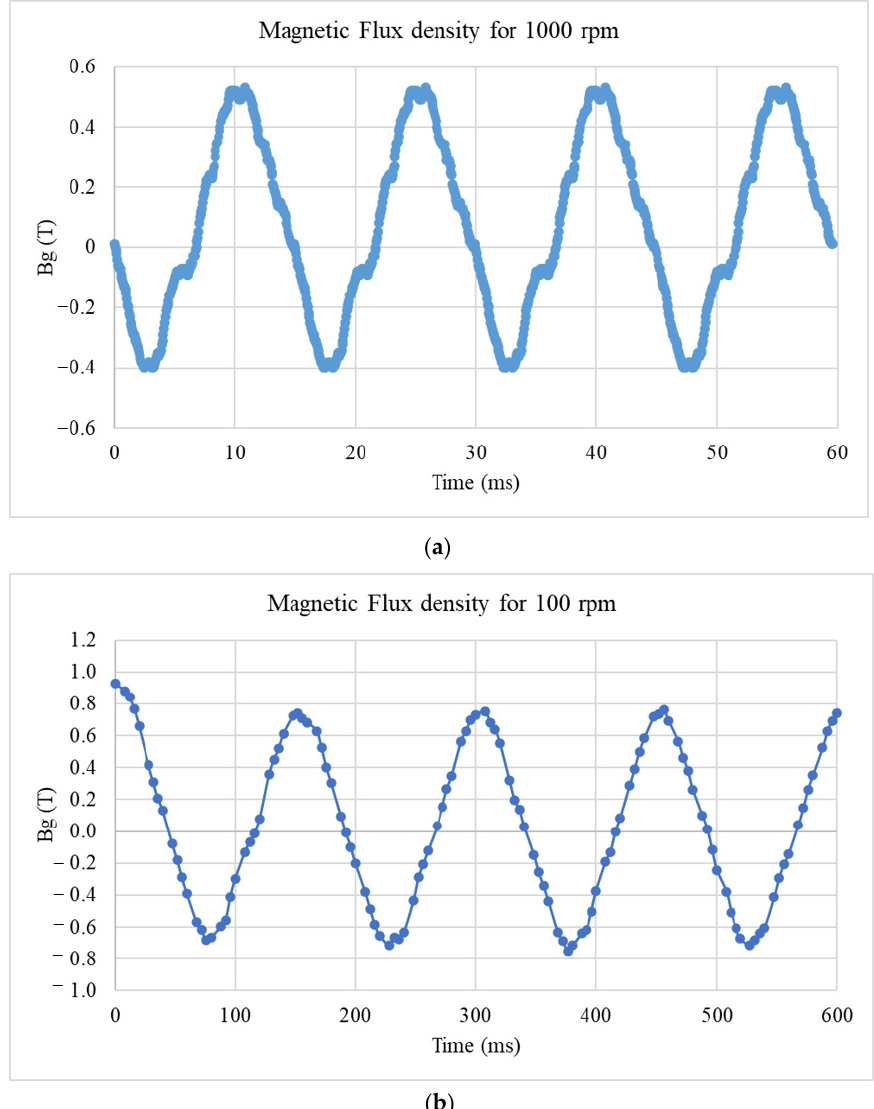
Figure 11. Magnetic flux density trend at 1000 rpm ( a ) and 100 rpm ( b ) of M 2 with configuration 10.